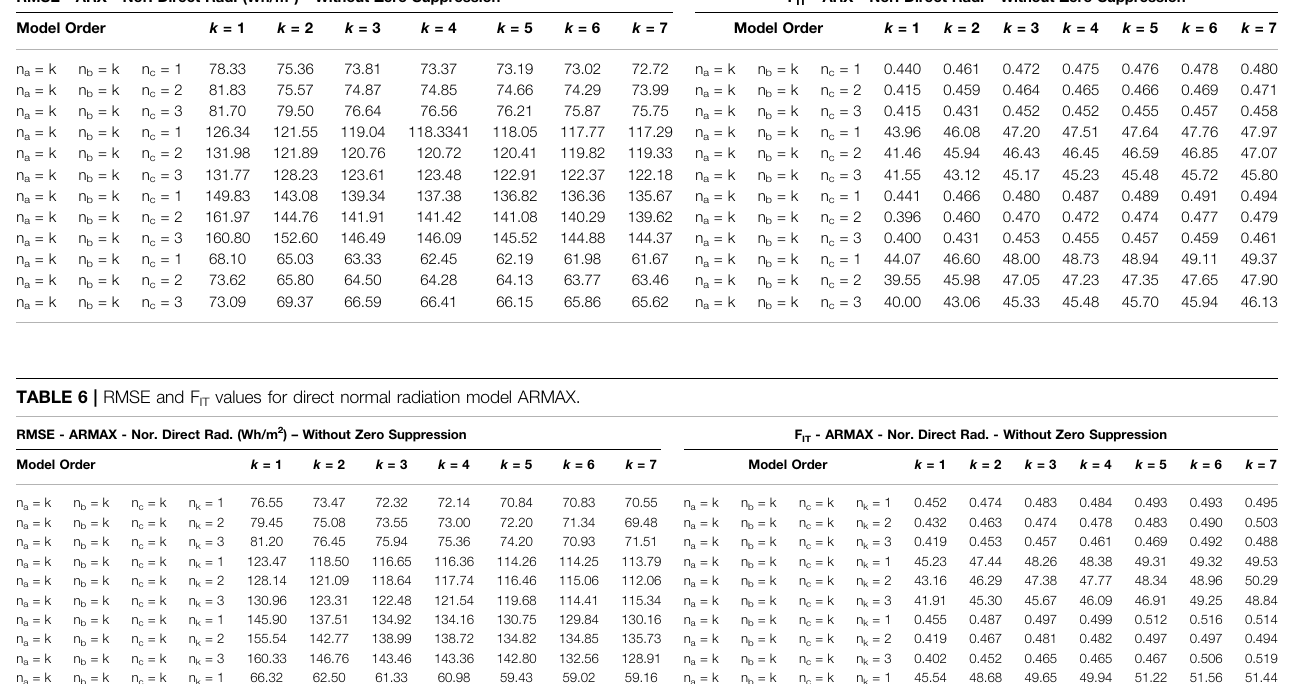
TABLE 5 | RMSE and F IT values for direct normal radiation model ARX. RMSE - ARX - Nor. Direct Rad. (Wh/m 2 ) - Without Zero Suppression F IT - ARX - Nor. Direct Rad. - Without Zero Suppression Model Order